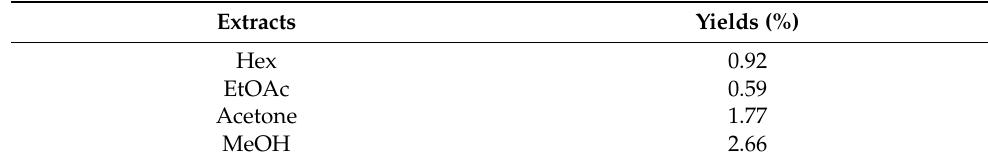
Table 1. Yields (%) of Erodium arborescens aerial part extracts.